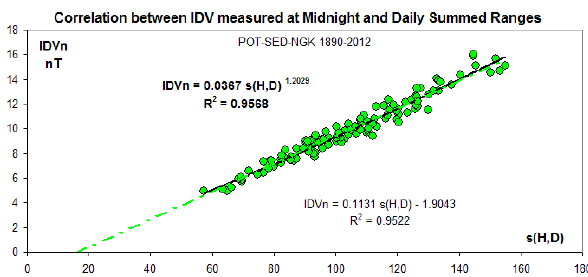
Figure A2. Correlation between yearly values of IDVn (midnight) and the average summed ranges for the day for H and D , s(H,D) , for the POT-SED-NGK composite series for the interval 1890–2012. The dashed line is the linear relation extrapolated to vanishing IDVn.